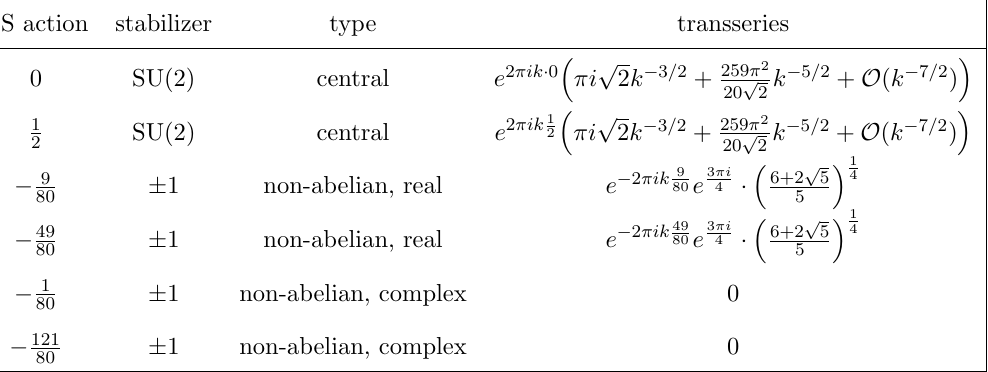
Table 17 . Transseries and classi(cid:12)cation of (cid:13)at connections on M ( overall factor of